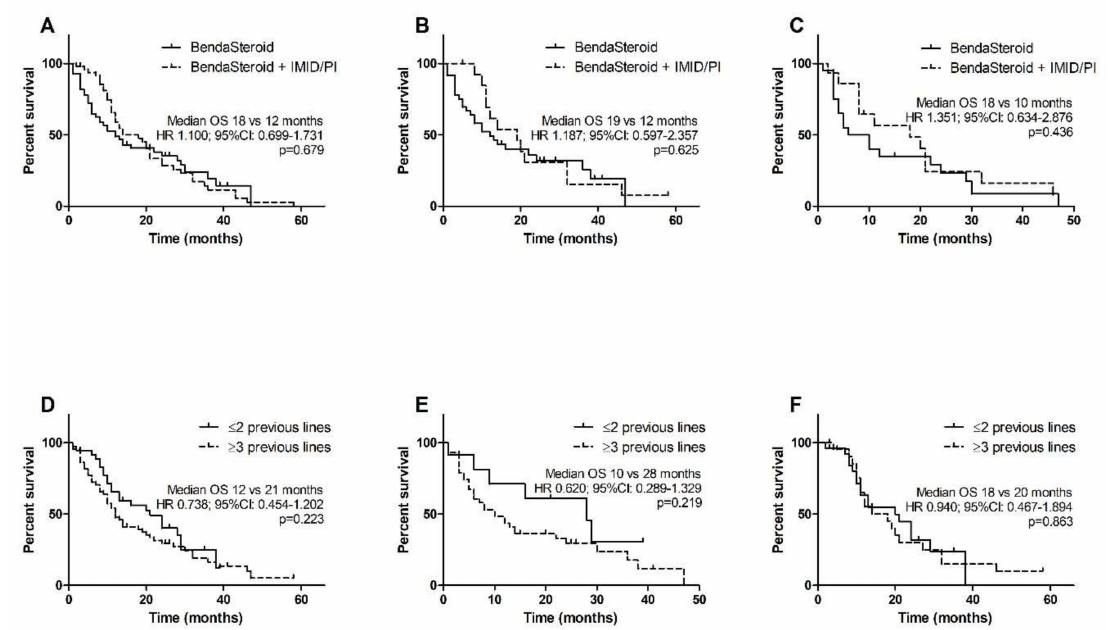
Figure 2. Kaplan–Meier estimates of overall survival (OS): ( A ) all patients; ( B ) subgroup of patients previously treated with lenalidomide and bortezomib; ( C ) subgroup of patients after ASCT; ( D ) impact of previous therapies number in all patients; ( E ) impact of previous therapies number in patients treated with bendamustine and steroid; ( F ) impact of previous therapies number in patients treated with bendamustine, steroid and